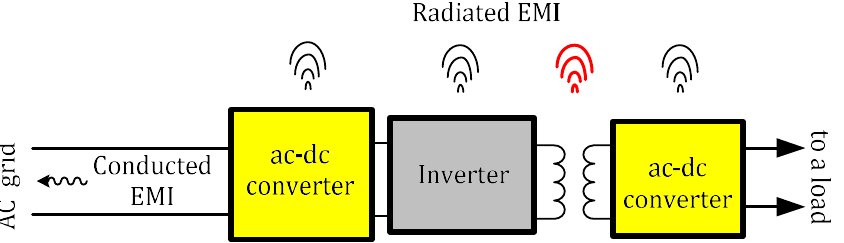
Figure 1. Simplified block diagram of the inductive-resonant WPT system-irradiating electromag- netic emissions.